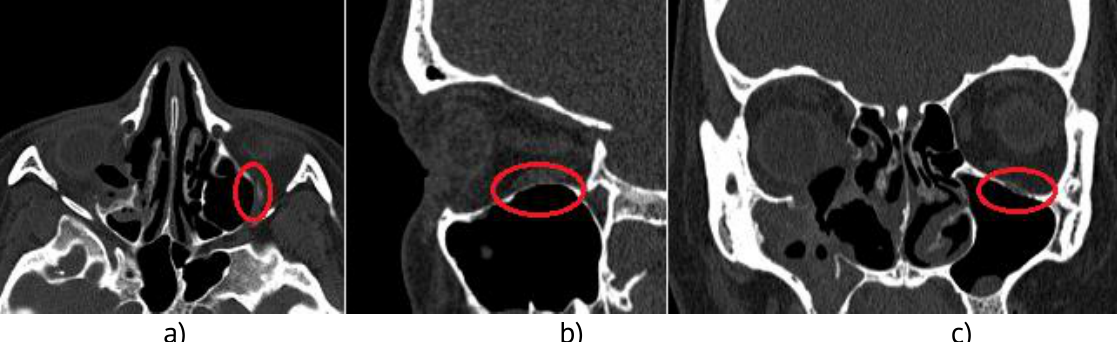
Figure 2. Images of the three projections of the patient's head: a – axial orientation; b – sagittal orientation; c – coronal